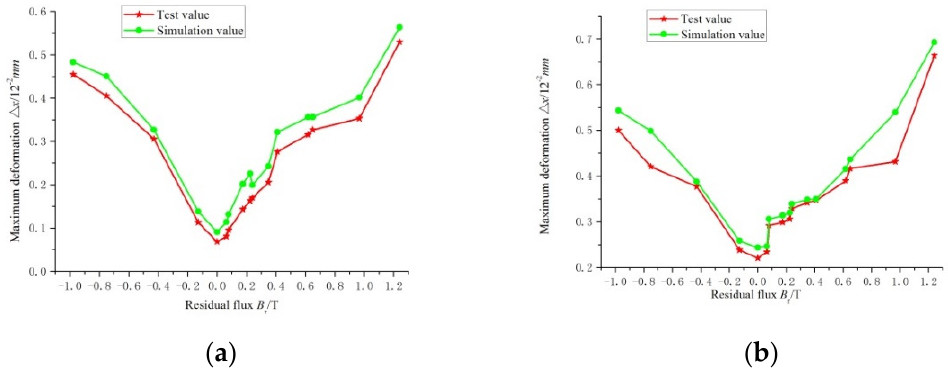
Figure 27. Windings deformation under different residual flux. ( a ) Line 1 pie winding deformation under different residual fluxes. ( b ) Line 5 pie winding deformation under different residual fluxes.